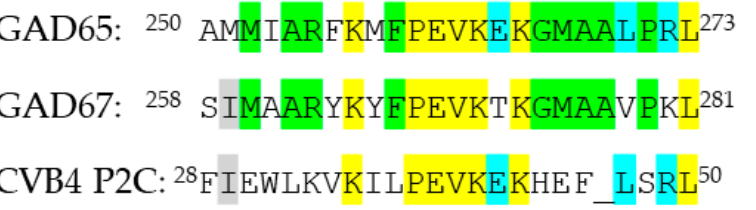
Figure 1. Sequence homology of glutamic acid decarboxylase (GAD)65, GAD67, and coxsackievirus (CVB)4 P2C peptides. Highlight in yellow represents amino acids found in all three peptides. Highlight in green represents overlap between GAD65 and GAD67. Highlight in blue represents overlap between GAD65 and CVB. Highlight in grey represents overlap between GAD67 and CVB. Similarity among GAD65, GAD67, and CVB4 P2C peptides are: GAD65/GAD67 = 67% overlap (16 identical amino acids), GAD65/CVB4 P2C = 42% overlap (10 amino acids), and GAD67/CVB4 P2C = 29% overlap (7 amino acids). The three peptides were used for generation of peptide